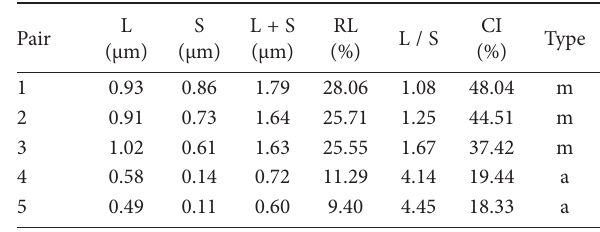
Table 1. Th e detailed measurement data of chromosome pairs of Trichogramma embryophagum.